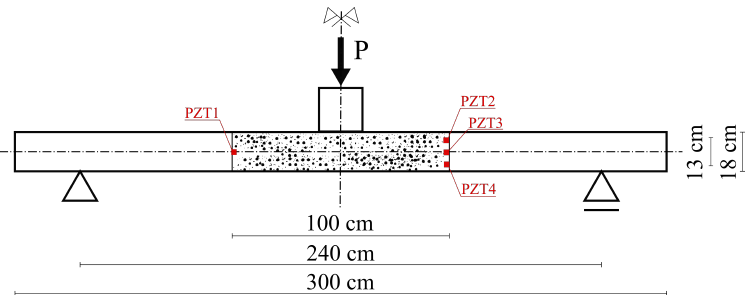
Figure 1. Dimensions of the specimen, location of observed area, and scheme of sensor